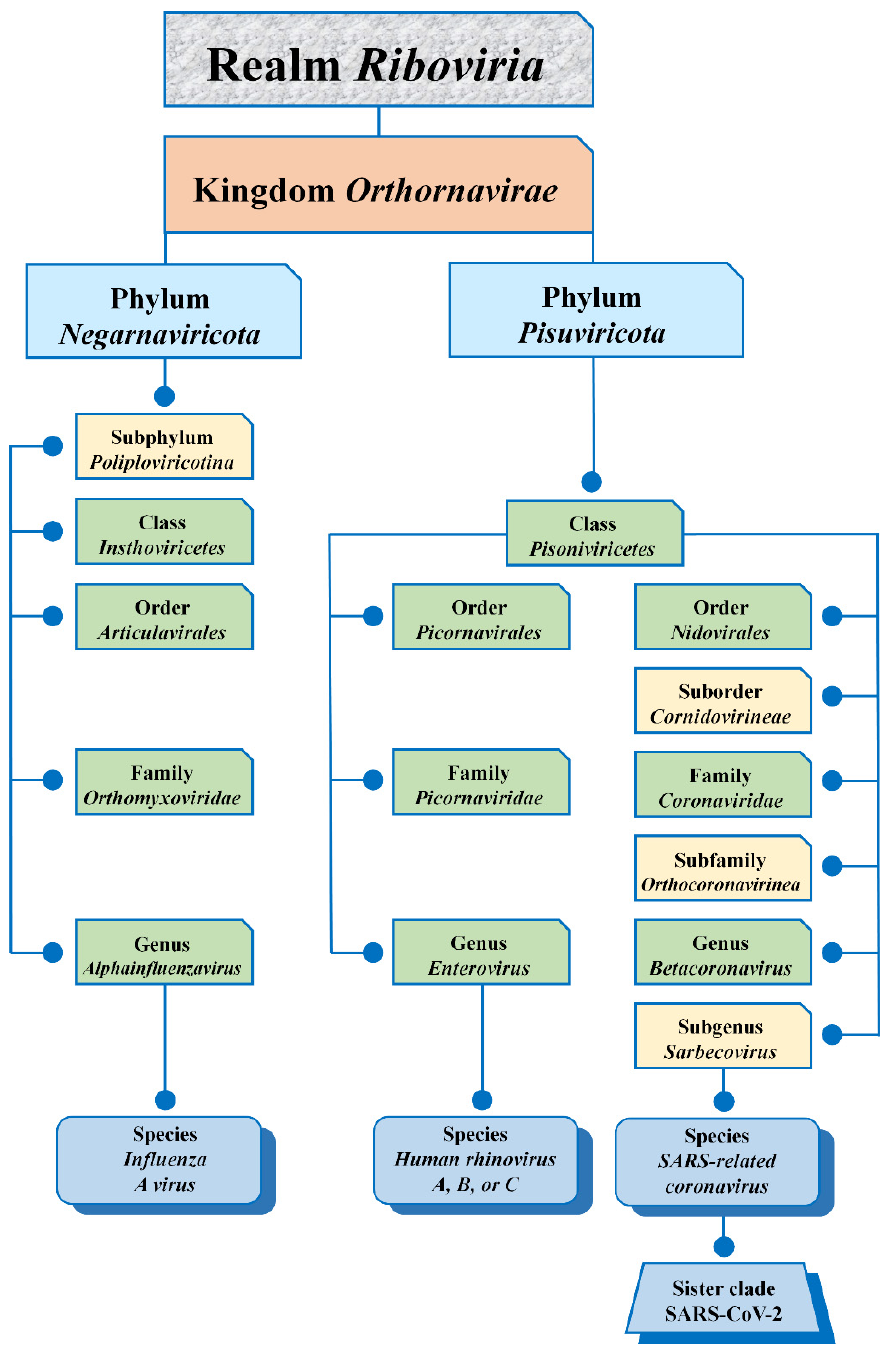
Figure 1. Taxonomic information on the three respiratory viruses discussed in this review [7,9]